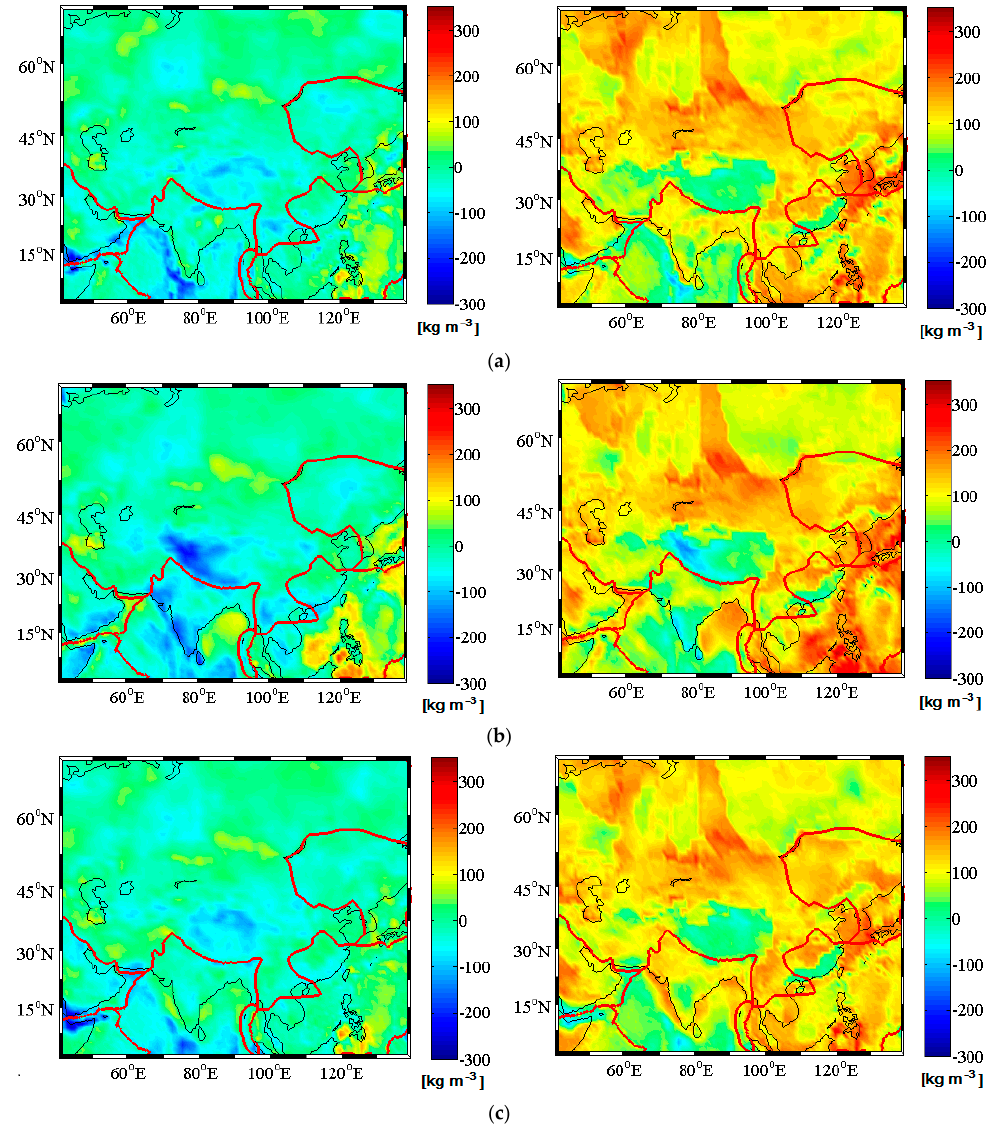
Figure 9. Moho density contrast differences of the combined solutions: ( a ) R1_CRUST1.0; ( b ) R2_GSMM and ( c ) R3_M13 taken with respect to the CRUST1.0 ( left panels ) and KTH1.0 models ( right panels ). Table 3. Statistics of the Moho density contrast from the CRUST1.0 and KTH1.0 models. Model